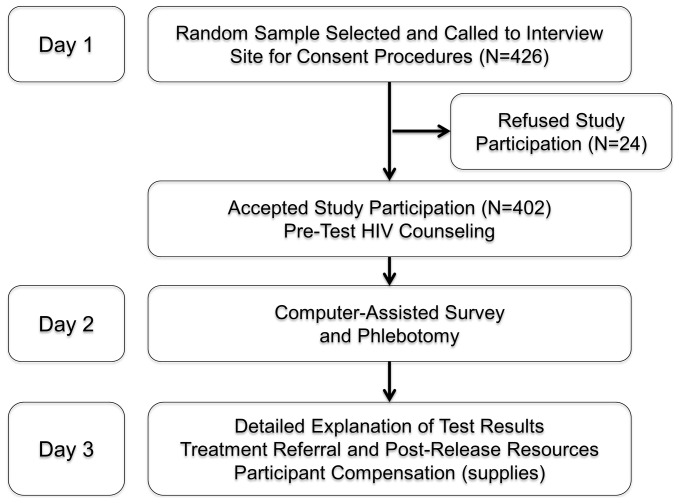
Study Activities and Procedures.